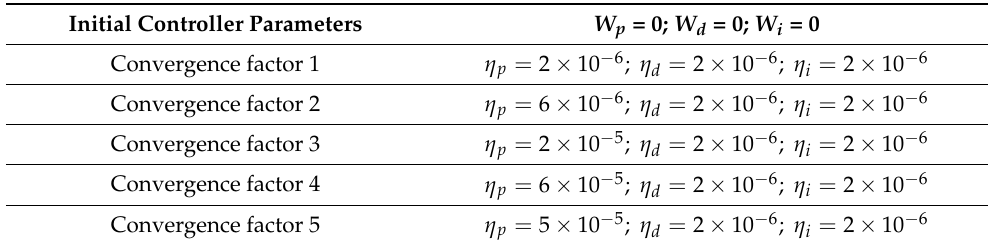
Table 6. Parameters of LMS-PID with different convergence factors.